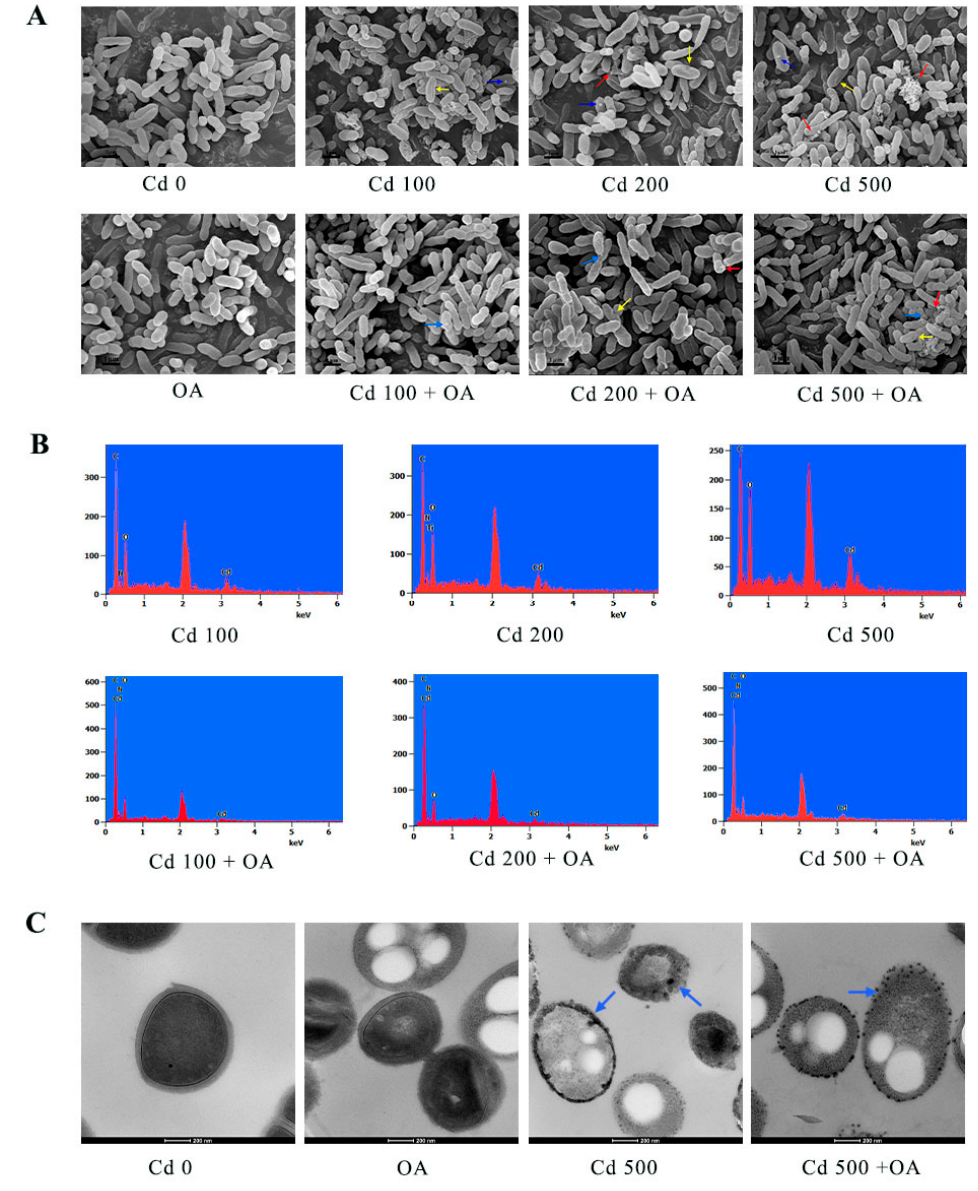
Figure 5. SEM ( A ), EDS ( B ), and TEM ( C ) images of B. cepacia under Cd exposure as well as co- treatment with Cd+OA. The EPS, Cd, and cell depressions are indicated by the red, blue, and yellow arrows, respectively. The Cd precipitates adsorbed on the cell surface and accumulated intracellularly are indicated by the blue arrows.